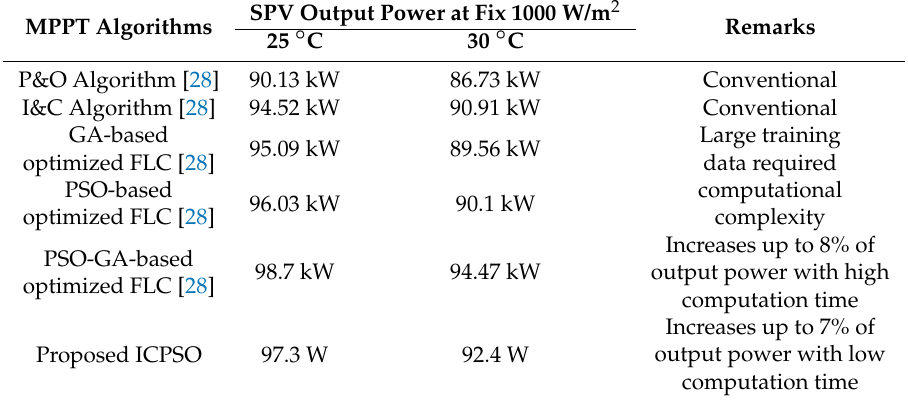
Table 2. Comparative performance analysis under variable temperature and constant irradiance